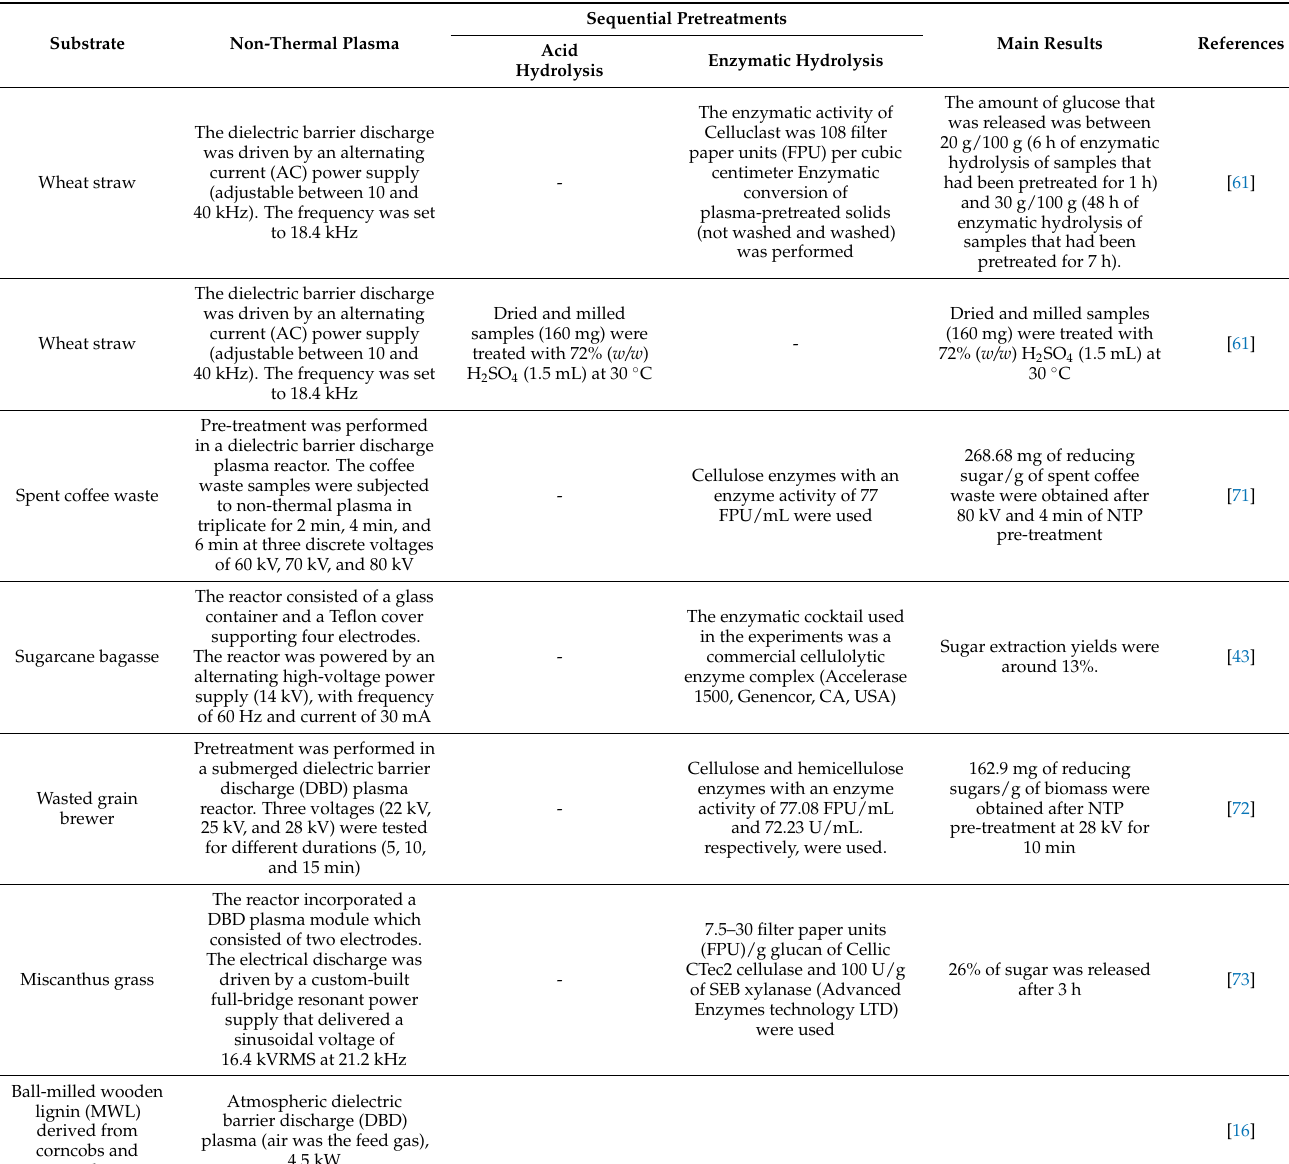
Table 3. Non-thermal plasma as a biomass pretreatment in a biorefinery